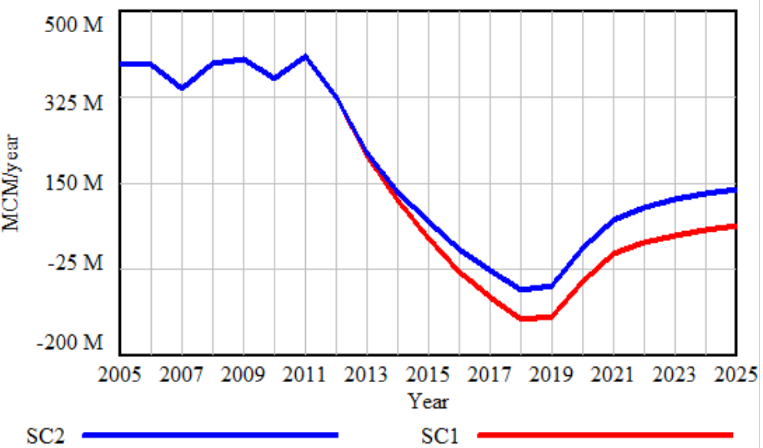
Figure 11. Impact of the Scarcity-Based Tariff on water